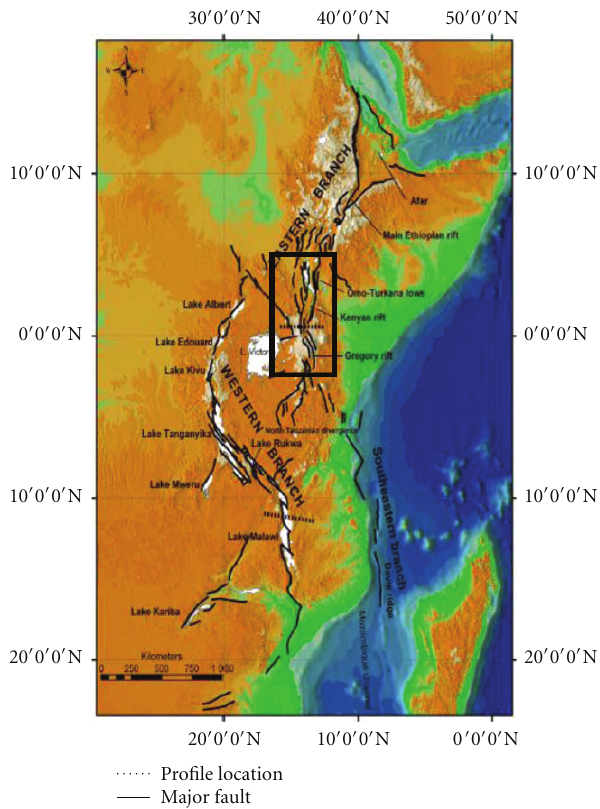
Figure 2: East African rift system showing the location of Kenya rift after